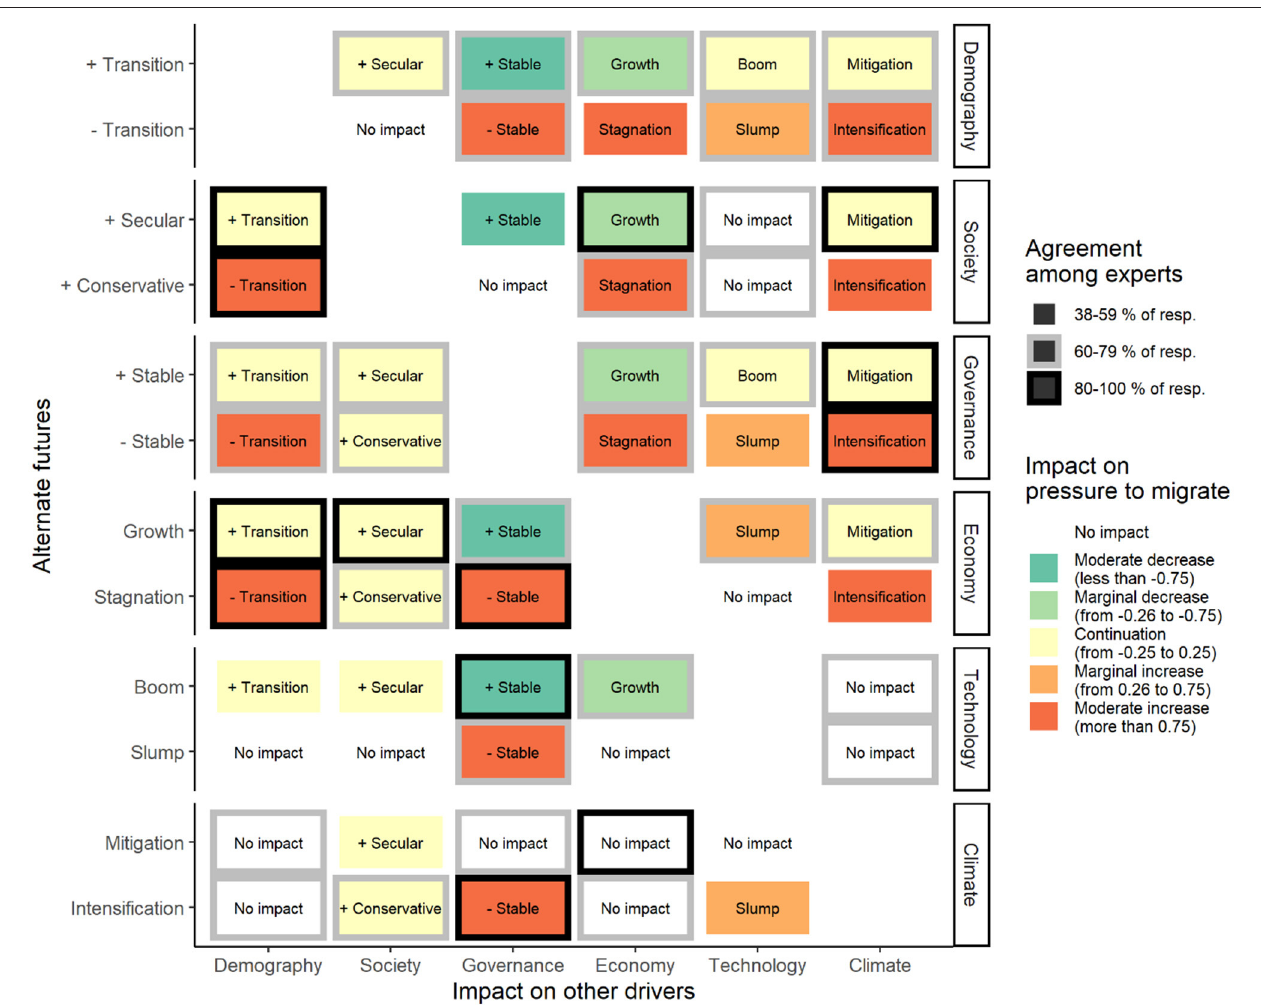
FIGURE 1 | Impact of alternate futures on other drivers and resulting impacts on the pressure to migrate from less developed countries, with levels of agreement among migration scholars. Rows represent alternate futures (left y-axis) in each driver (right y-axis). Columns represent the impacted drivers. The direction of the impact is indicated in boxes which reflect the most commonly chosen answer among migration scholars. Different levels of darkness of the frame around each box indicate the proportion of respondents who chose the indicated direction of impact. Colors show the size of the impact on migration of each future indicated in the boxes, averaged among all migration